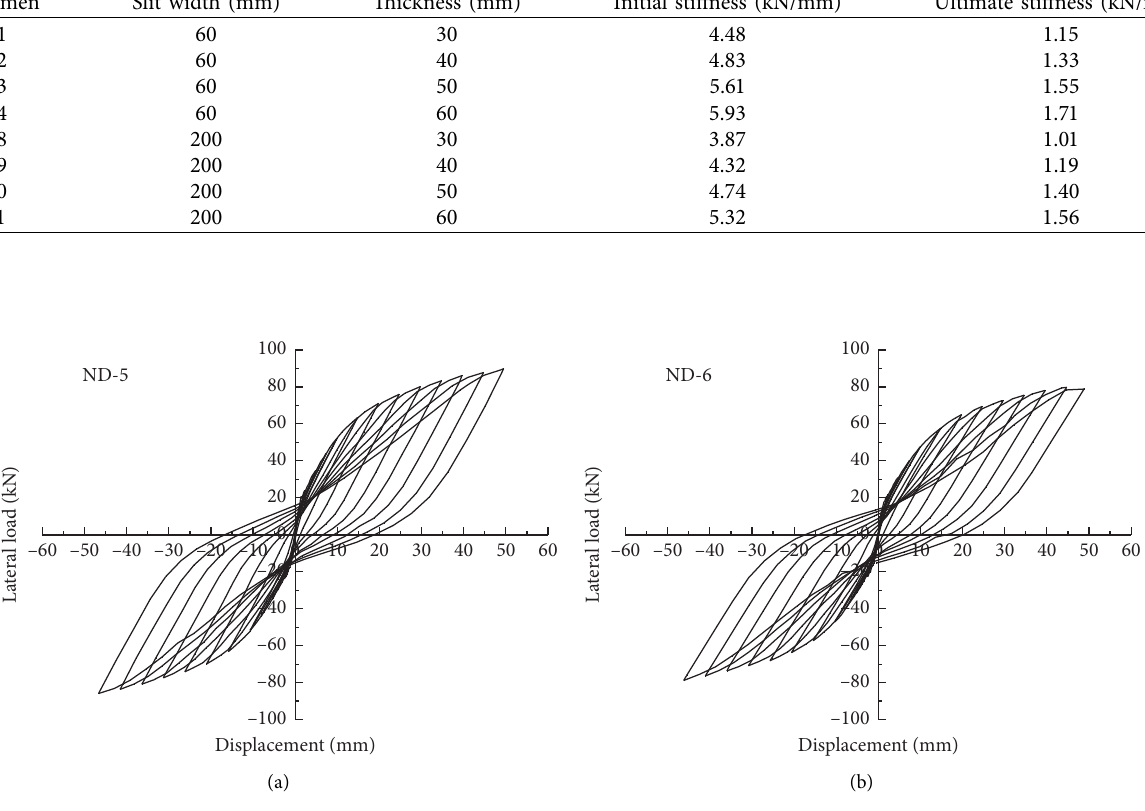
Figure 27: Hysteretic curves of Slit width 20mm. (a) Z -direction constrain. (b) Without constrain.